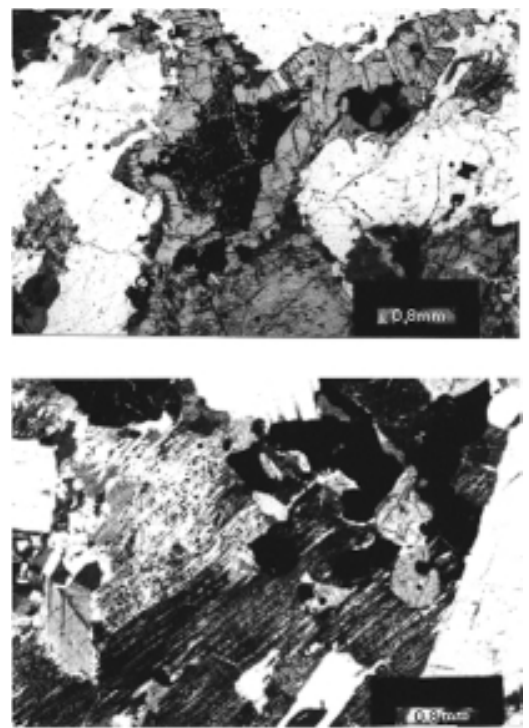
Figs. 11-12 – (Fig. 11) – Mantled pyroxenes surrounded by a coronaofmagnesio-to-tschermakitic-hornblende, whichgrades to edenitic and Fe-edenitic compositions. (Fig. 12) – Elongated eyeshaped exsolution lamellae of CPX in OPX as well as OPX in CPX parallel to the (100)